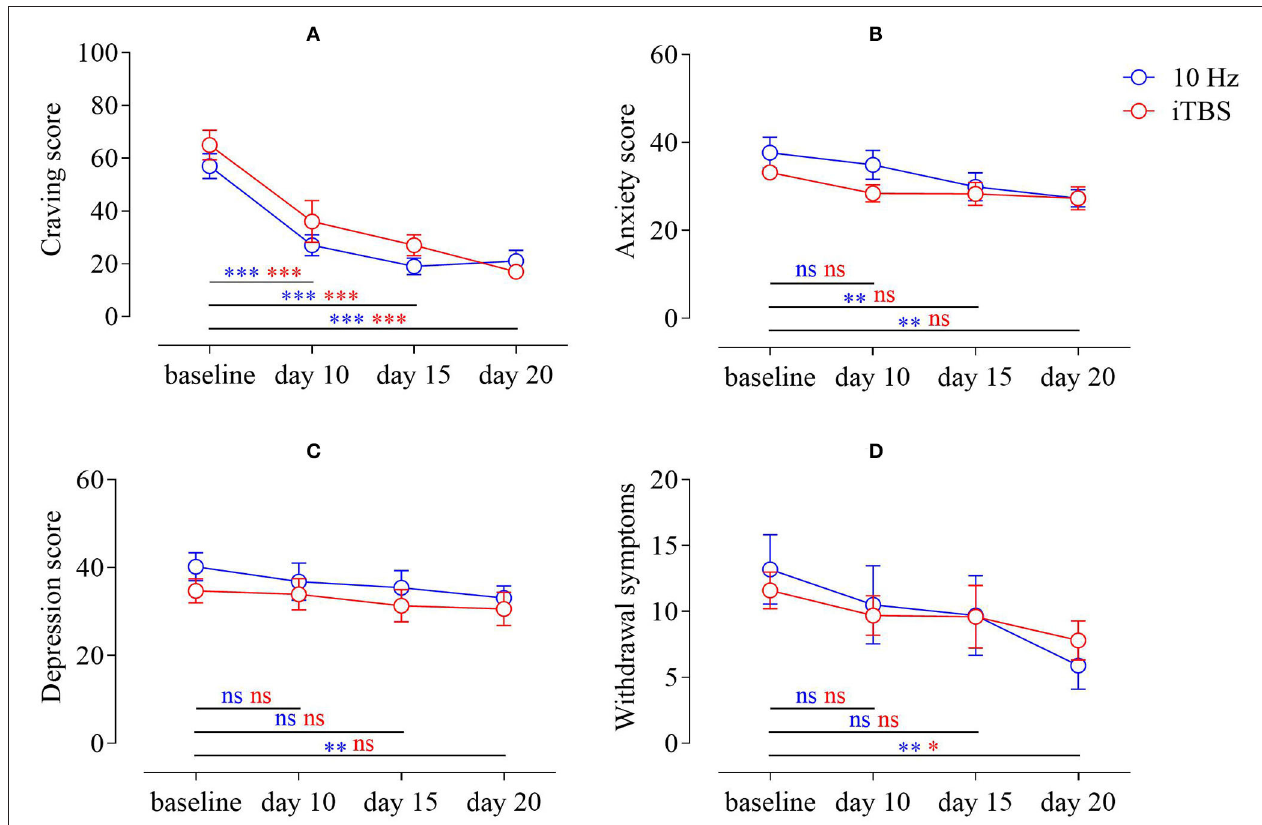
FIGURE 2 | (A) Change in craving scores of MA addicts in the two groups; (B) change in anxiety scores of MA addicts in the two groups; (C) change in depression scores of MA addicts; (D) change in withdrawal symptom scores of MA addicts in both groups